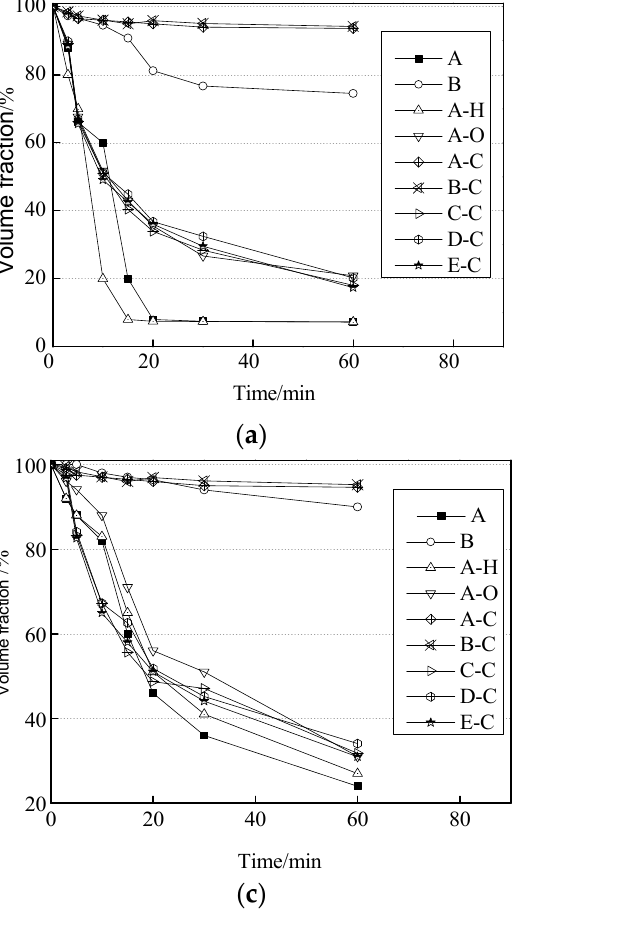
Figure 5. Relationship between settlement volume and time. ( a ) NAC addition: 1%; ( b ) NAC addition: 2%; ( c ) NAC addition: 3%; ( d ) NAC addition: 5%.